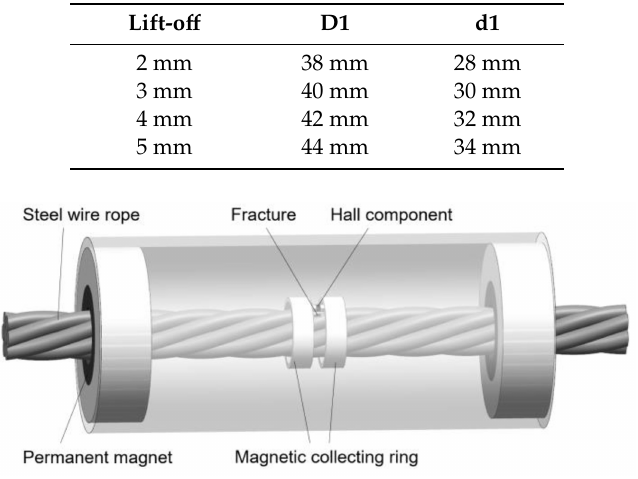
Figure 10. Overall simulation model.